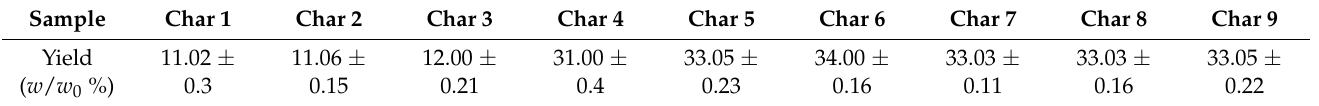
Table 2. Char yields at different operating temperatures and residence times.